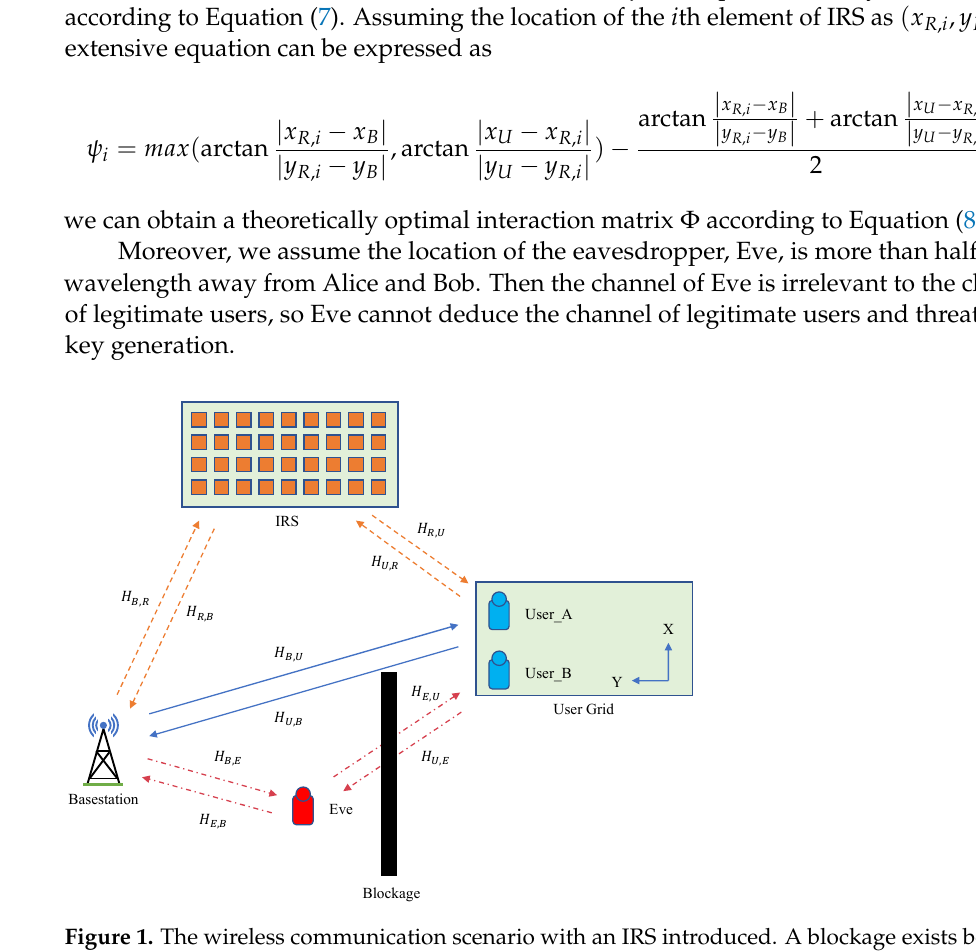
Figure 1. The wireless communication scenario with an IRS introduced. A blockage exists between the base station and user devices, including User_A and User_B, and interferes with the wireless signal. The received signal at User_B is interfered with more severely compared with User_A.